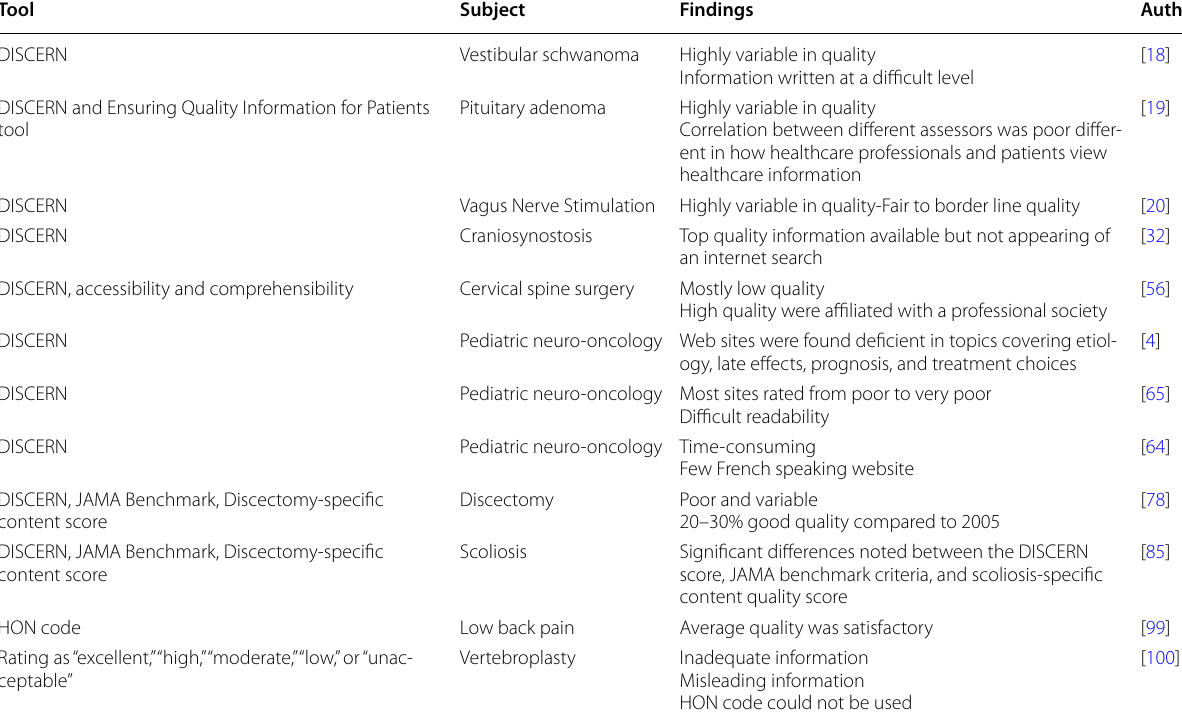
Table 1 Neurosurgery related‑evaluated websites